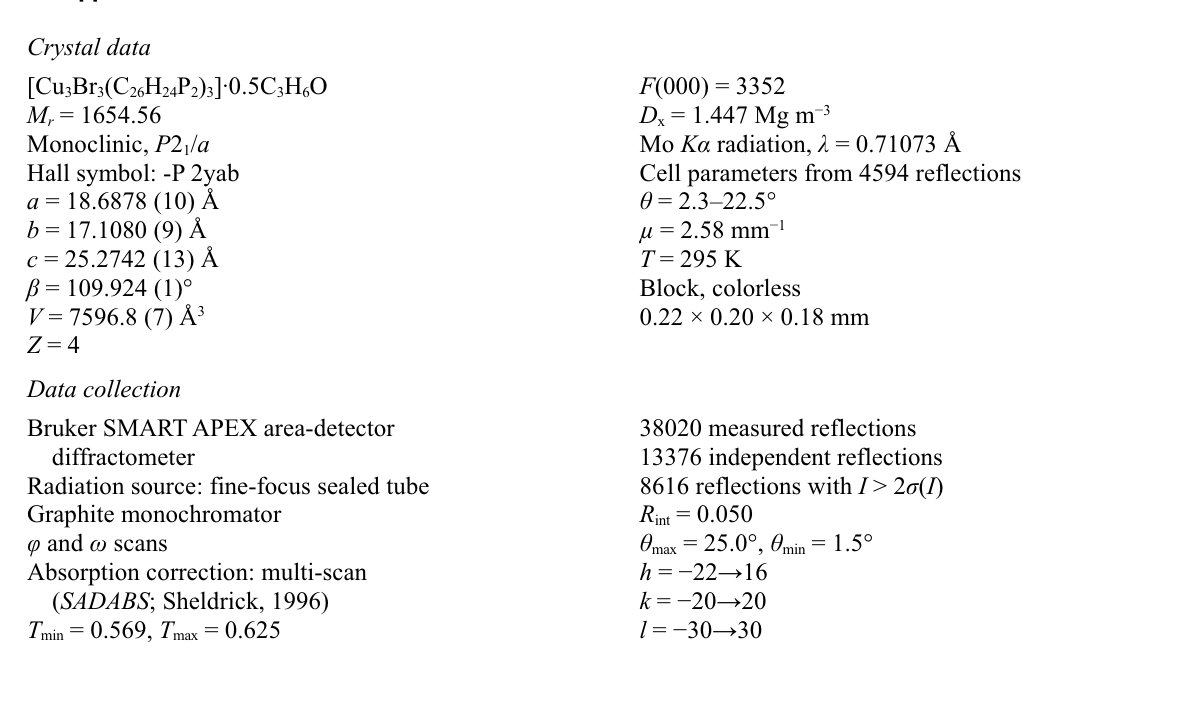
Crystal packing of (I) showing the intermolecular C—H···Br hydrogen bonds as dashed lines. Tris[ µ -1,2-bis(diphenylphosphino)ethane]-1:2 κ 2 P : P ′ ; 1:3 κ 2 P : P ′ ;2:3 κ 2 P : P ′ -di- µ -bromido- 1:2 κ 4 Br:Br-bromido-3 κ Br- tricopper(I) acetone